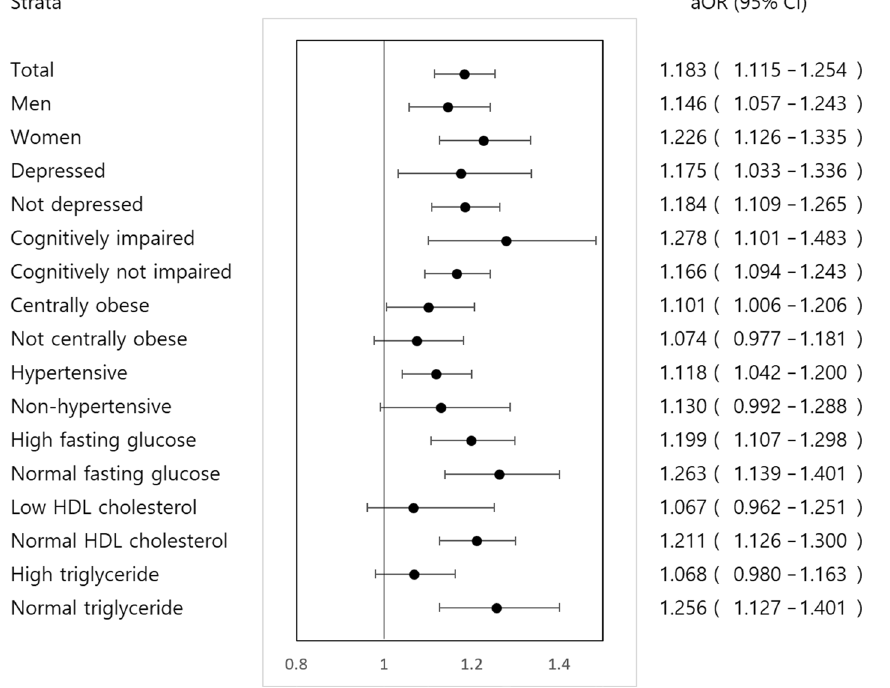
Figure 3. Forest plots showing stratified analyses of the association of the timed up and go test with metabolic syndrome. * aOR adjusted odds